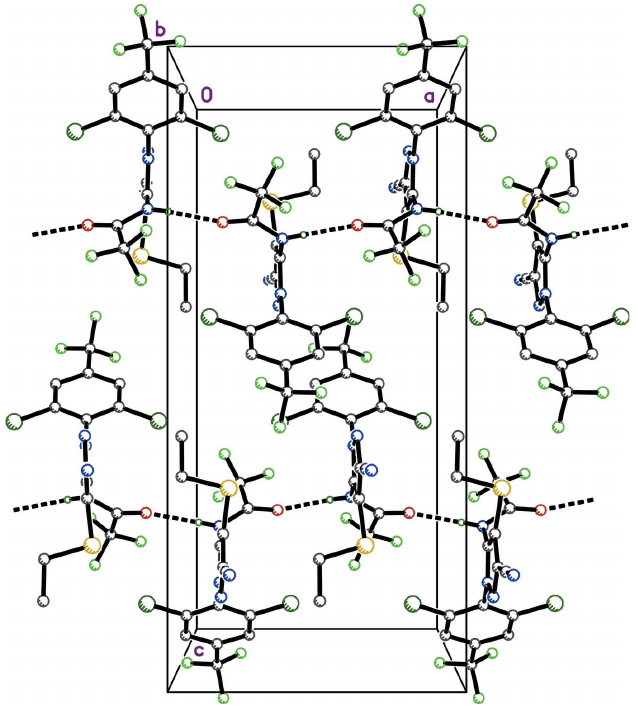
Figure 2 A packing plot of I showing strong hydrogen-bonded chains (thick dashed lines) along the a -axis direction.